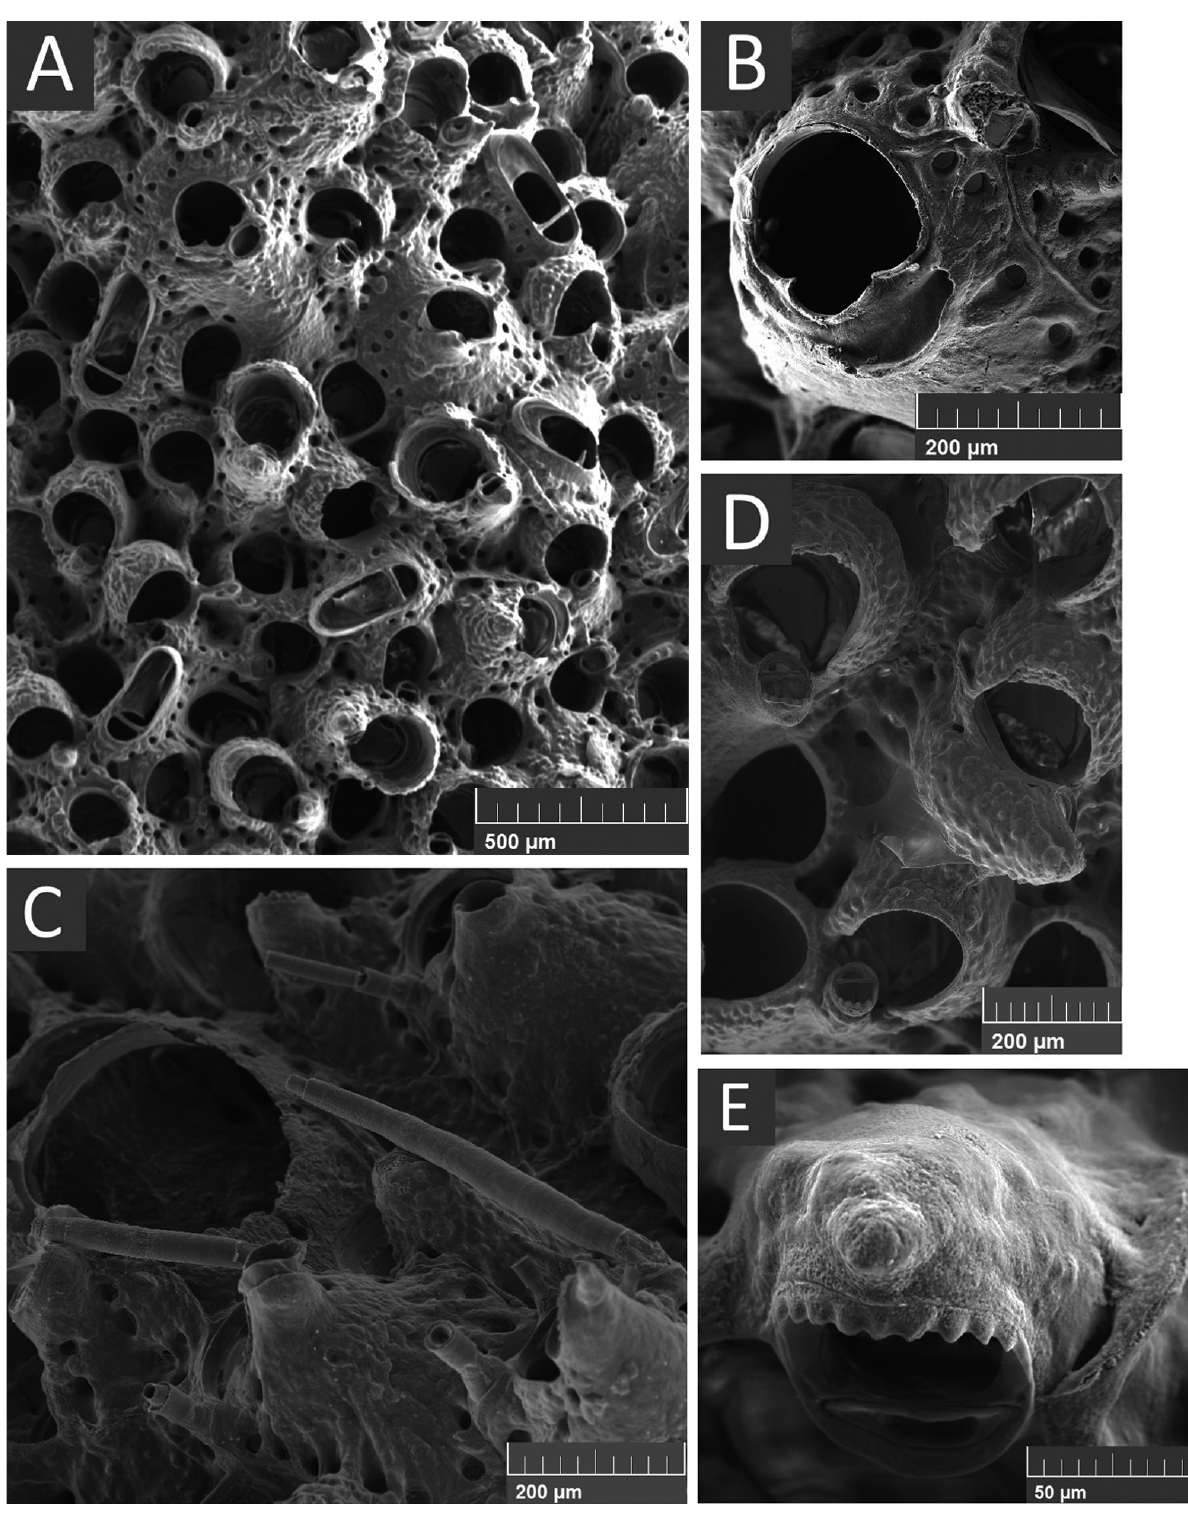
Fig. 4. – Celleporaria brunnea specimens from the western Mediterranean Sea: (A) colony irregular in shape; (B) close-up of the orifice and the areolar pores; (C) close-up of the spines; (D) zooids with suboral avicularia shown both erected and non-erected; (E) close-up of the suboral avicularia with the dentate